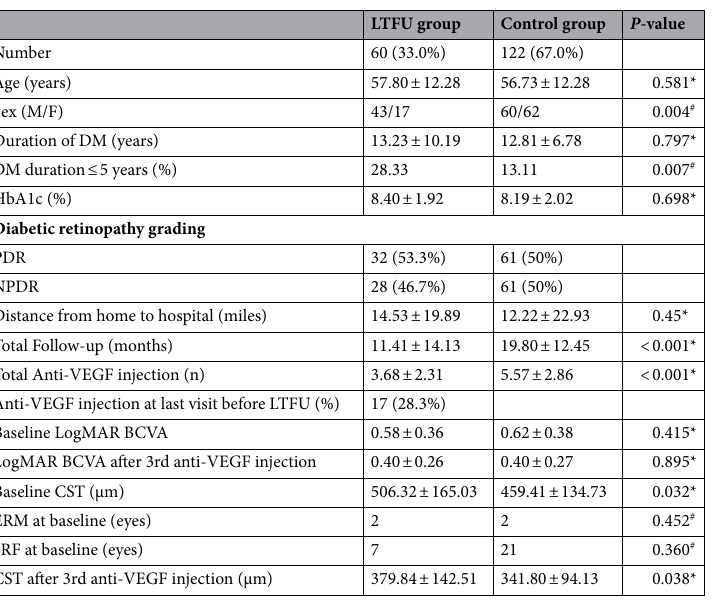
Table 1. Clinical characteristic of diabetic macular edema patients lost to follow-up for more than 1 year. LTFU; lost to follow-up, DM; diabetes mellitus, VEGF; vascular endothelial growth factor, PDR; proliferative diabetic retinopathy, NPDR; non-proliferative diabetic retinopathy, CST; central subfield thickness, ERM; epiretinal membrane, SRF; subretinal fluid. *Independent t-test after testing for normality using Shapiro–Wilk test. # Chi-squared